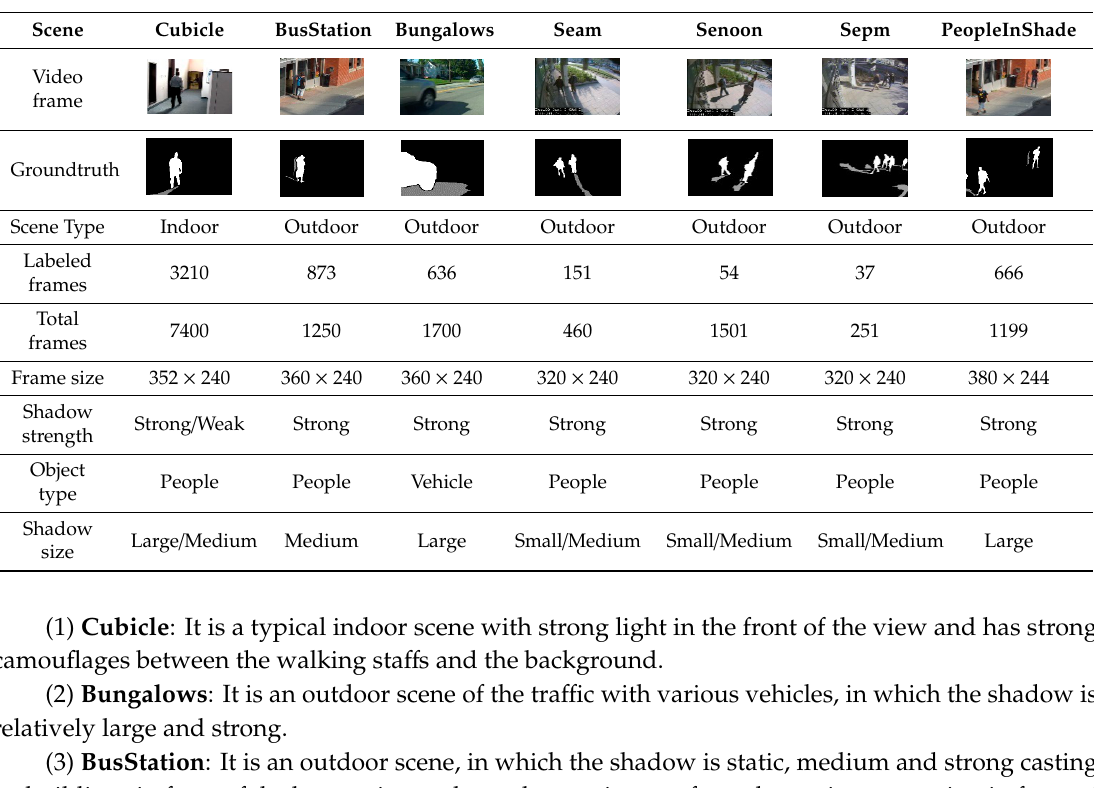
Table 2. The detail information of a large dataset.